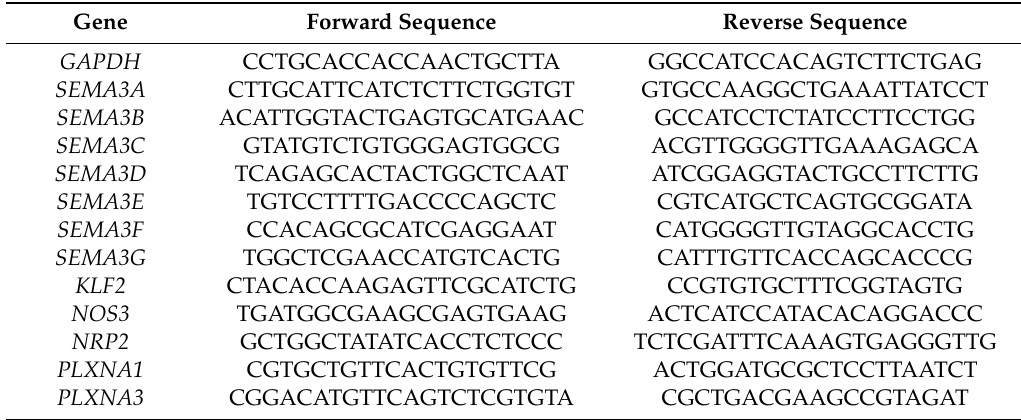
Table 1. List of primers